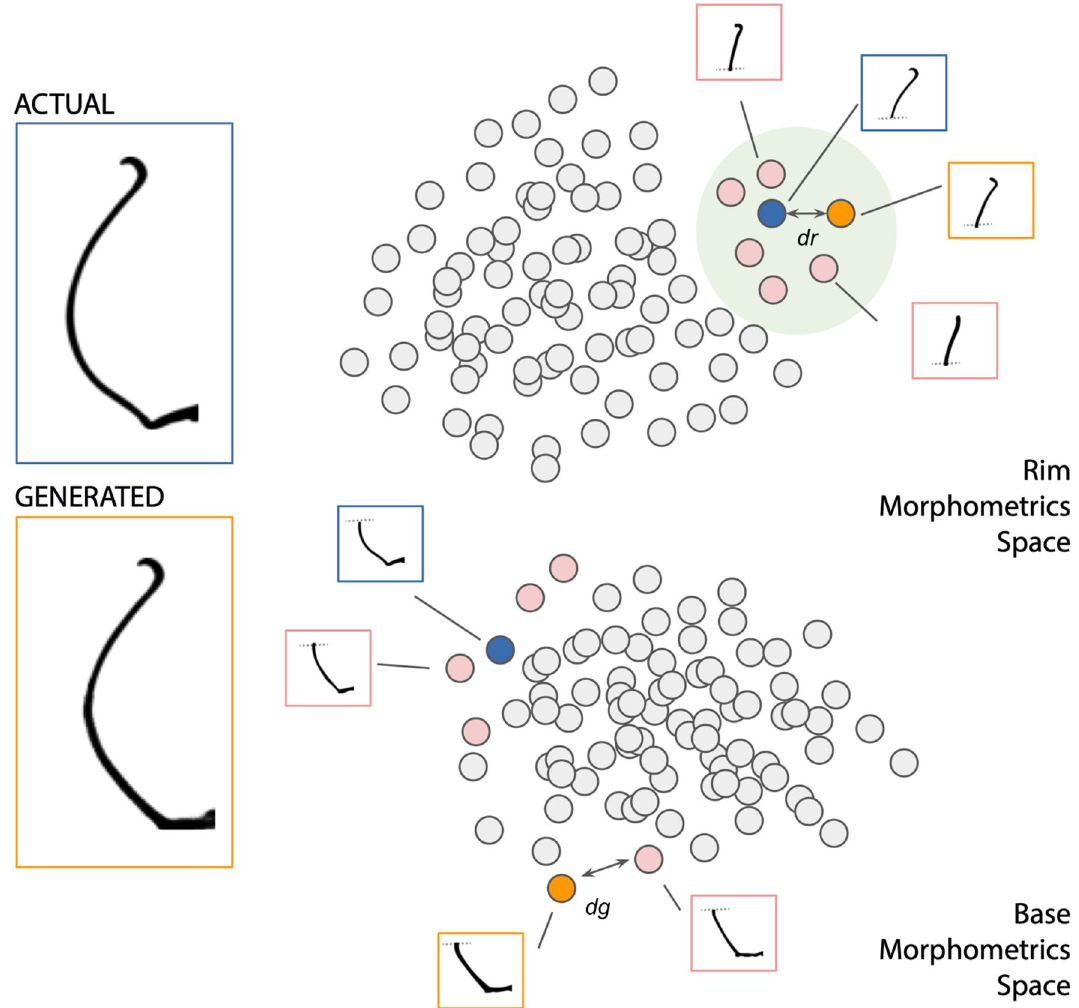
Figure 2. Shape validation. In orange, generated profile with an actual rim. In blue, complete actual Iberian profile. In pink, the k-closest neighbors of the actual fragment (excluding the input rim). dr is the distance between the actual and the generated rim. dg is the minimum distance (in the base morphometric space) between the generated fragment and its K neighbors in the rim morphometric